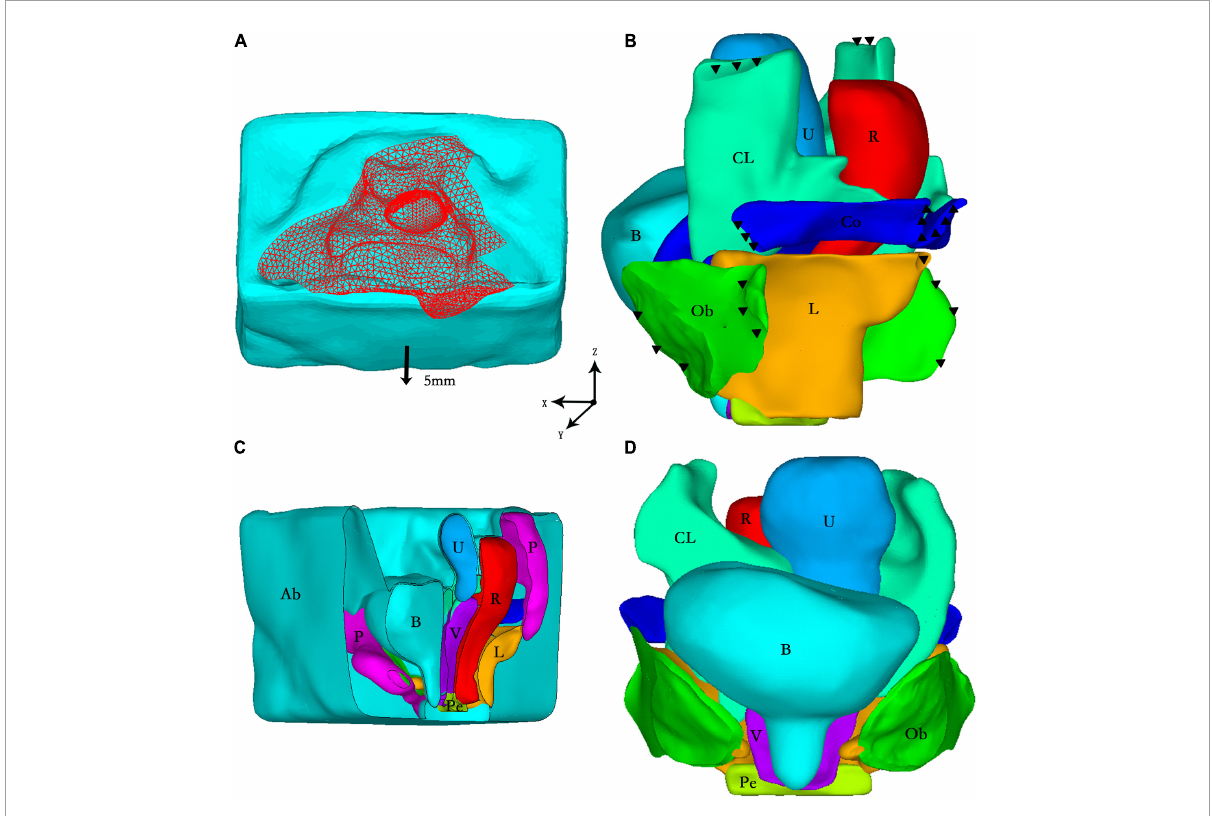
FIGURE1 (A) Loading conditions: vertical peritoneal uniform pressure load (red) and forward displacement (arrow); (B) Boundary conditions: fixed constraint (black triangle) in the side view of the model; (C) The sectional view of the full model; (D) The front view of organs and supporting tissues. Ab, abdominal cavity; B, bladder; CL, cardinal ligaments; U, uterus; R, rectum; Co, coccygeus; Ob, obturator internus; L, levator ani muscle; P, pelvis; Pe, perineal body; V,